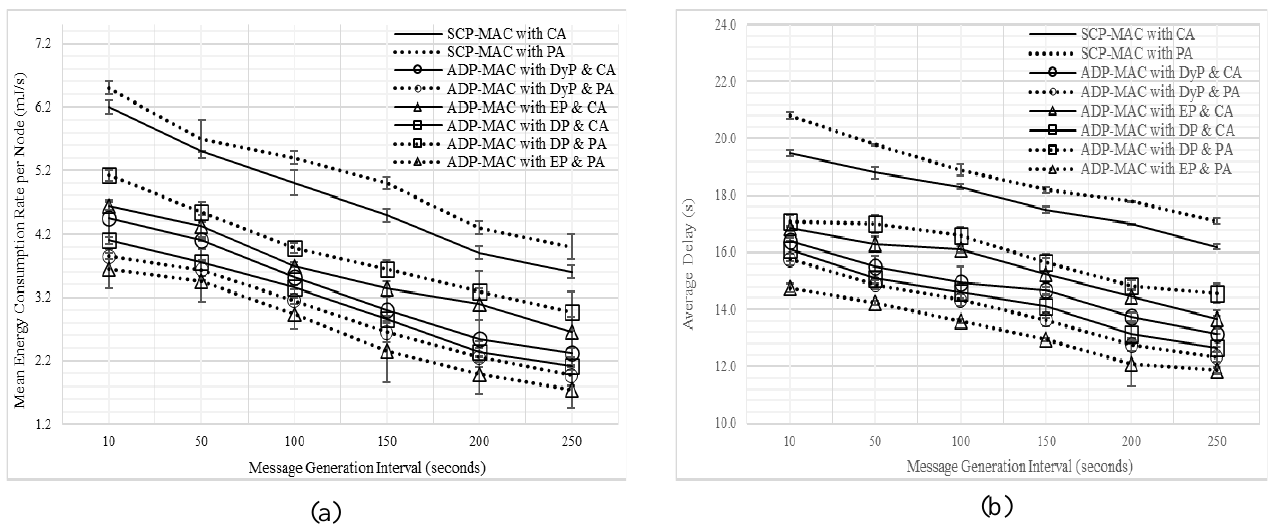
Fig. 5. Performance evaluation of ADP-MAC for varying traffic load (a) Energy (b)